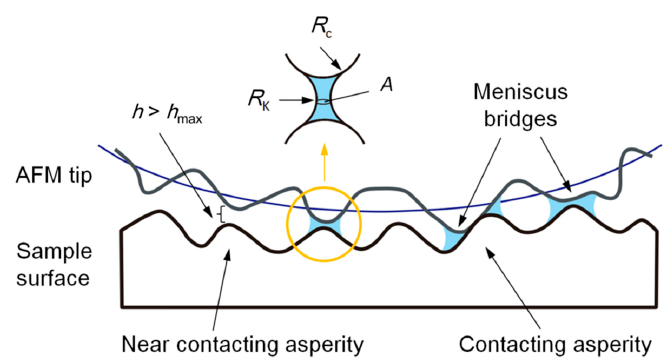
Figure 20. Schematic diagram showing multi-asperities contact in ambient air where water meniscus forms at contacting and near-contacting asperities. When the height h between two asperities is larger than h max , water meniscus cannot be formed at near-contacting asperities. The radii of tip and Kelvin radii are R and r m , respectively. The cross section of a single water meniscus is A . Reprinted from Ref. [126], Copyright 2018, with permission from IOP publications.